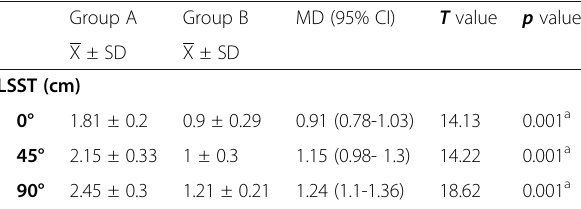
Table 2 Comparison of LSST between groups A and B Group A Group B MD (95% CI) T